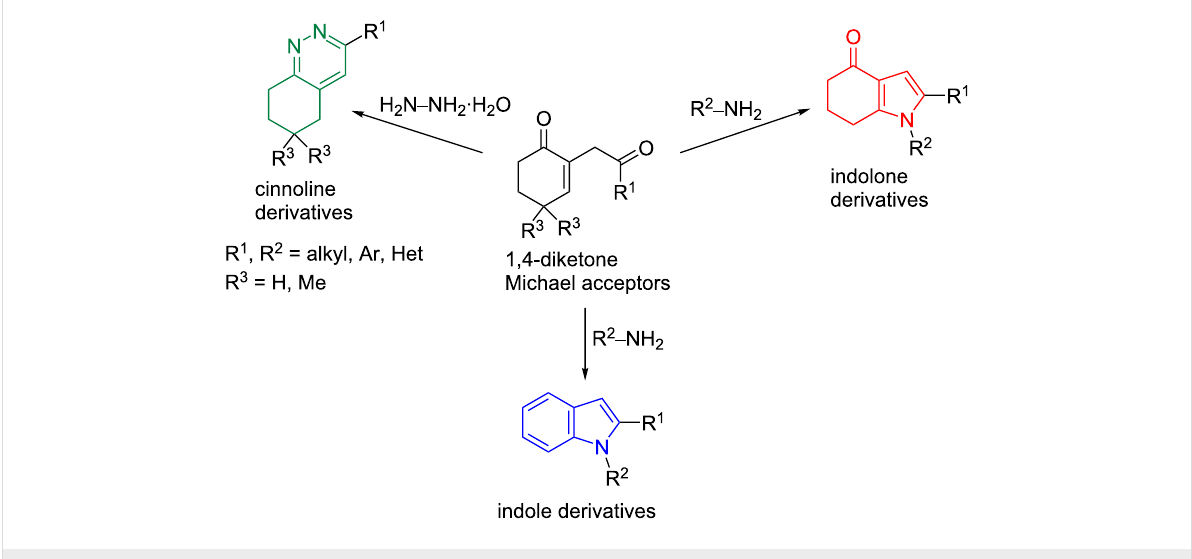
Scheme 1: General strategy to access indole, indolone, and cinnoline derivatives from 1,4-diketones.